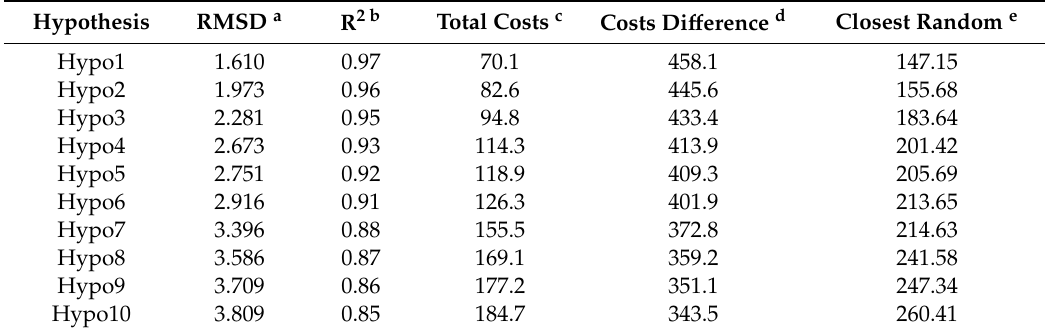
Table 4. Parameters of 10 generated PH4 pharmacophoric hypotheses for InhA inhibitor after Cat-Scramble validation procedure (49 scrambled runs for each hypothesis at the selected level of confidence of